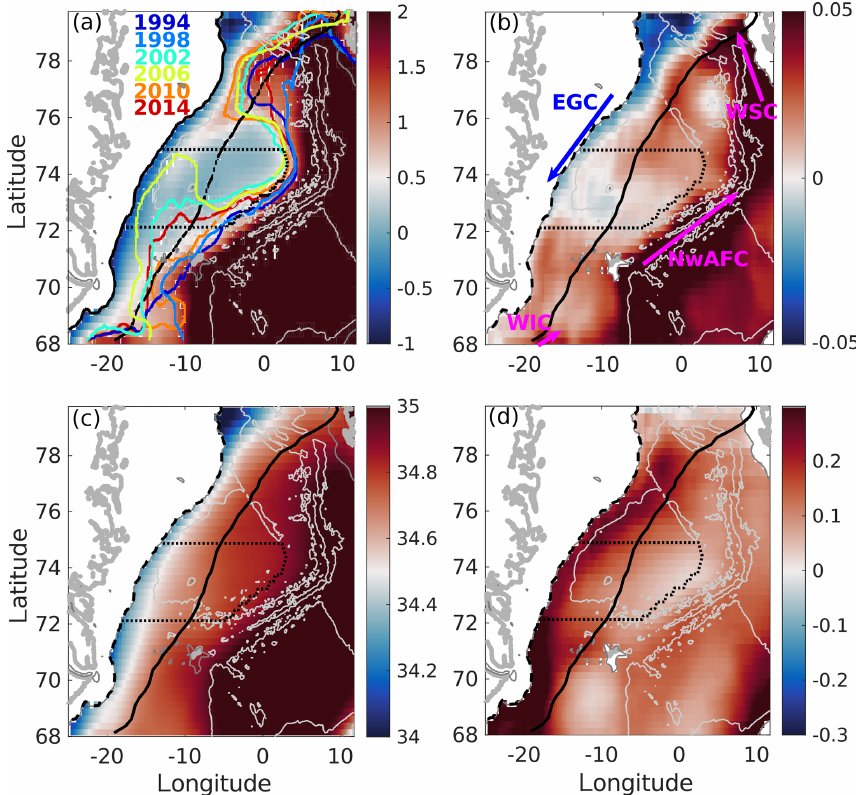
Figure 5. Marginal sea ice zone (enclosed in black lines) and thermohaline water properties averaged in the upper 50m layer during the cold season (October–April). (a) Time-mean (1993–2016) temperature ( ◦ C) in MIZ and location of 2 ◦ C isotherm in November for selected years; (b) linear temperature trend ( ◦ Cyr − 1 ) in the upper 50m-layer from 1993 to 2016; (c) time-mean (1993–2016) salinity in MIZ; (d) linear salinity trend in the upper 50m layer from 1993 to 2016. In panel (b) , EGC is the East Greenland Current, NwAFC is the Norwegian Atlantic Front Current, NIIC is the North Icelandic Irminger Current and WSC is the West Spitsbergen Current. Dotted lines in panels (b) and (d) mark the region where Odden tongue is